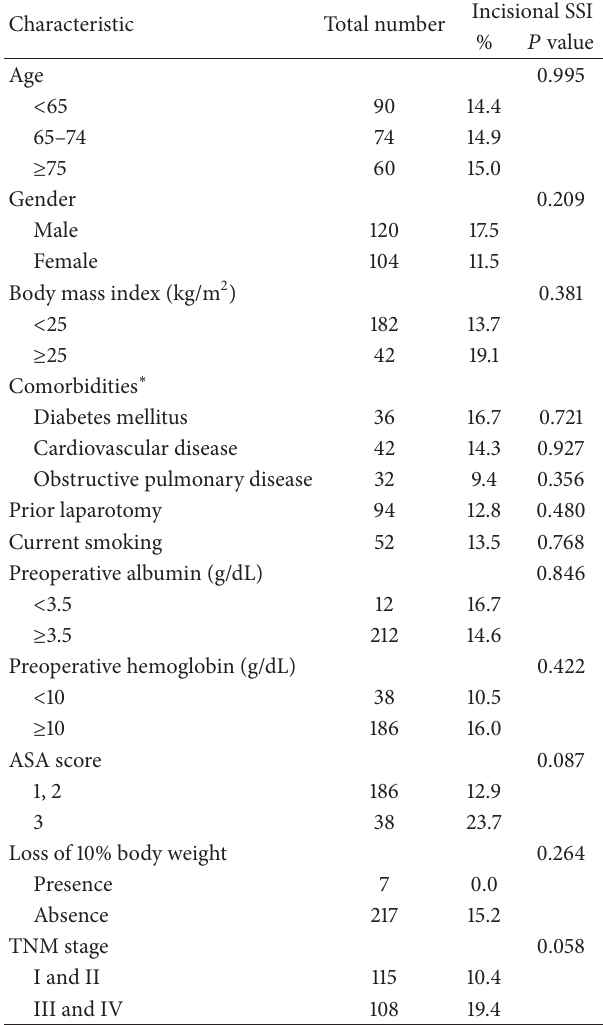
Table 1: Patient